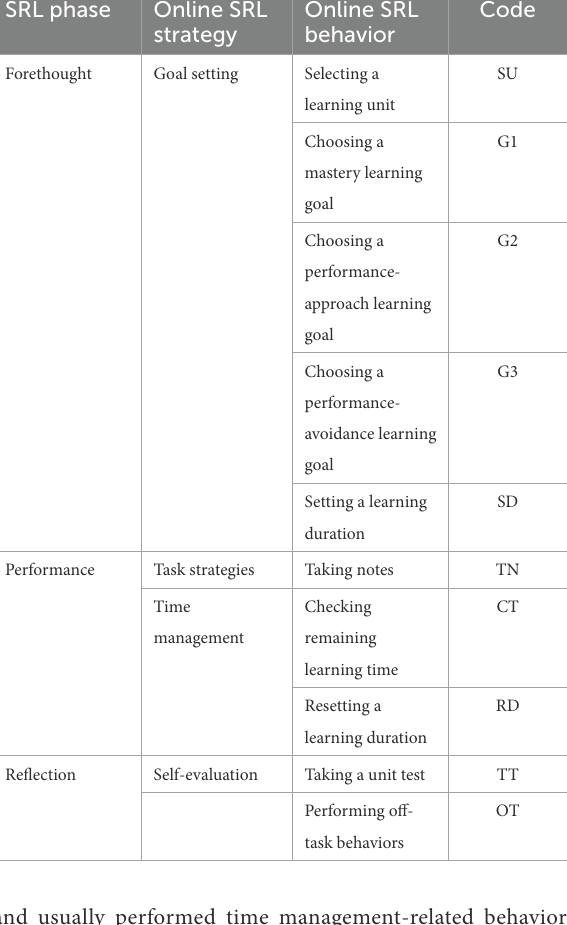
TABLE 1 The coding scheme of online SRL behaviors. SRL phase Online SRL